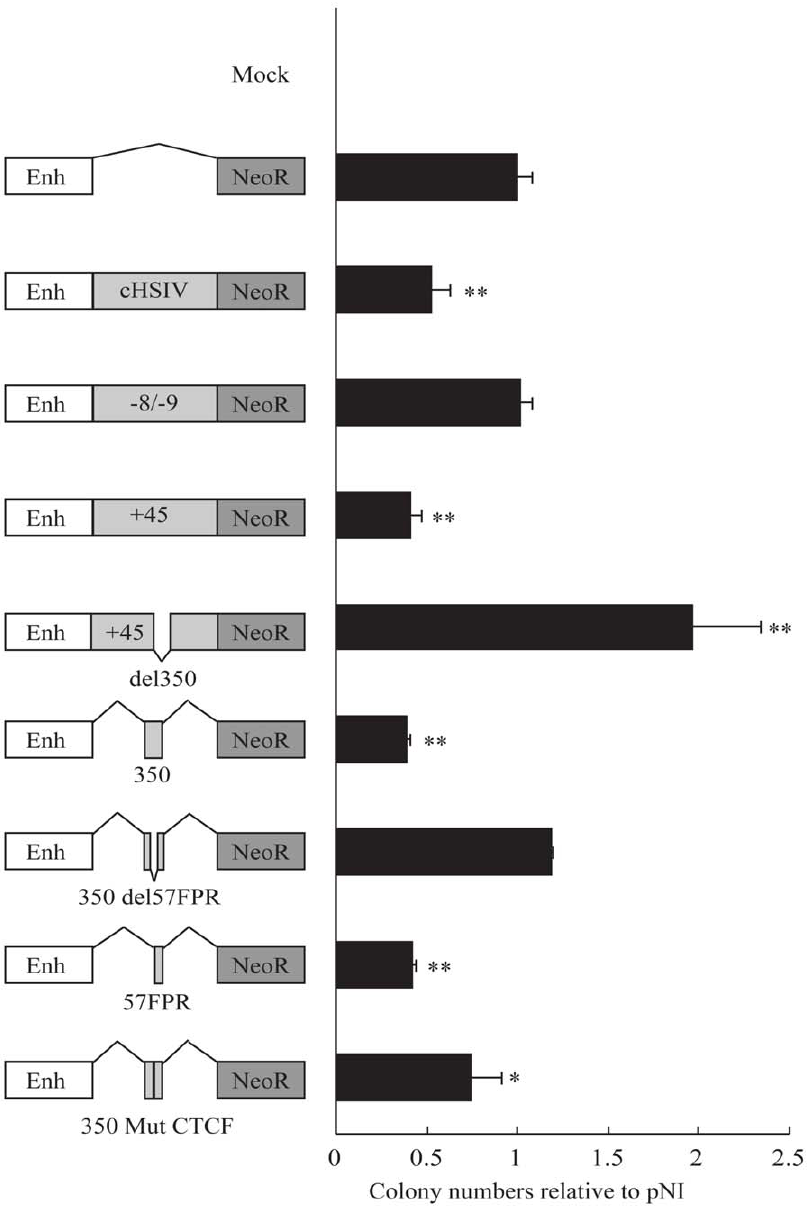
Figure 4. The + 45 element function as an insulator and this activity is dependent on the 57FPR. The left panel represents the different constructs diagrammatically. Data is presented as K562 colony numbers relative to the control pNI construct containing only the ß-globin HS2 enhancer and the neomycin resistance promoter. The positive control (1.2 kb fragment containing the chicken HSIV insulator) reduces the number of colonies by 50%, with similar insulation observed from the 1.76 kb + 45 element containing the 350 bp core element and the 57FPR. Deletion of either the 350 bp core from the + 45 or deletion of the 57FPR from the 350 bp core, both removed the insulator function of the elements. Furthermore, mutation of the CTCF-binding site in the 350 bp core element significantly reduced the insulator function of the 350 bp core element. The data represents the mean 6 SD of relative colony numbers from 3 independent experiments each performed in triplicate. * p , 0.05, ** p , 0.01 when compared to